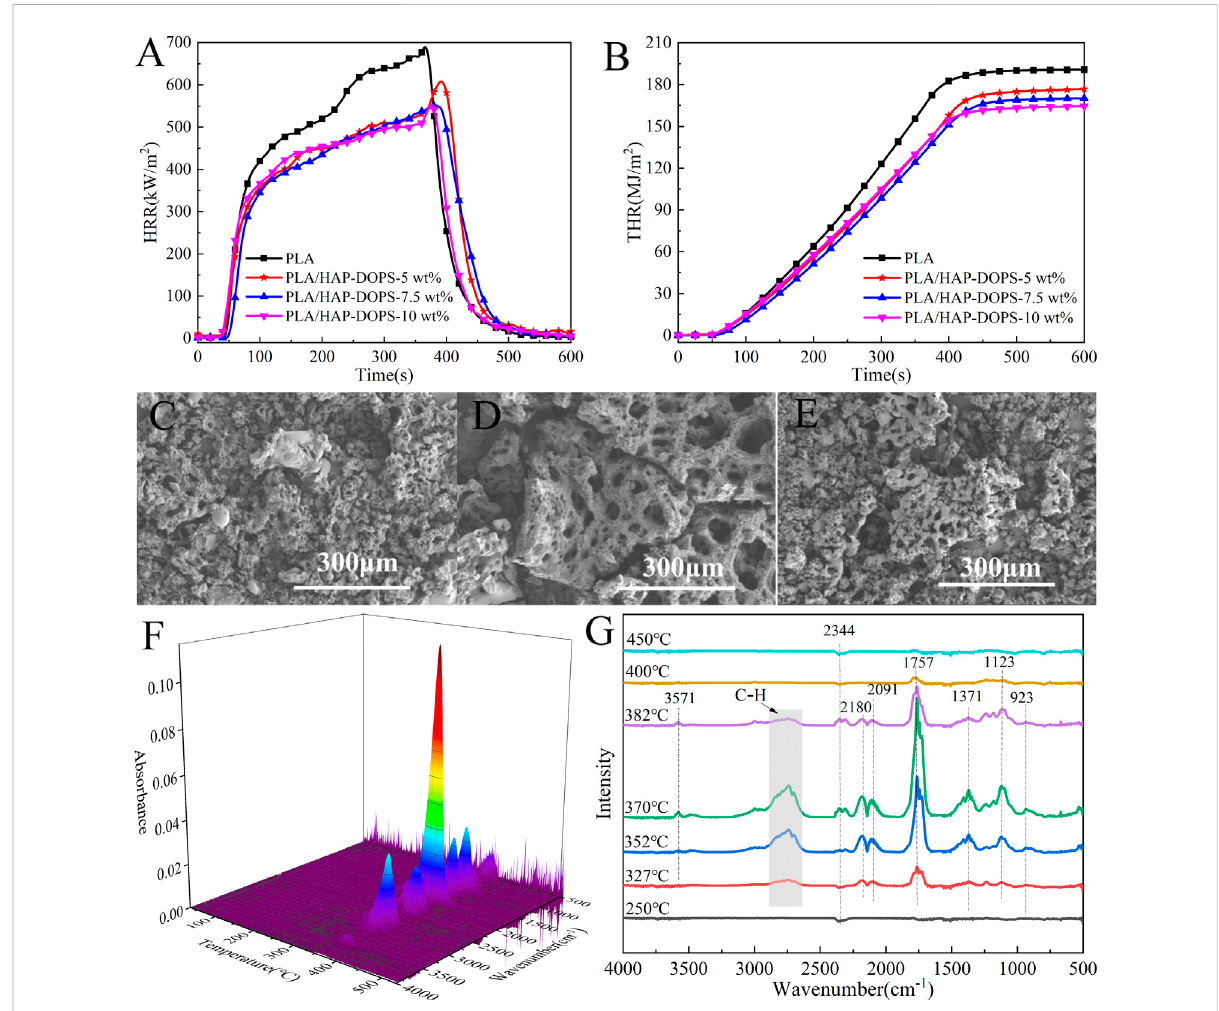
FIGURE 2 FIGURE 2 (A) HRR curves of PLA and PLA composites; (B) THR curves of PLA and PLA composites; (C) , (D) , (E) SEM images of char residues of PLA/HAP-DOPS-5 wt%, PLA/HAP-DOPS-7.5 wt% and PLA/HAP-DOPS-10 wt%; (F) The 3D TG-FTIR spectrum of PLA/HAP-DOPS; (G) The absorbance of pyrolysis products of PLA/HAP-DOPS at different temperatures.